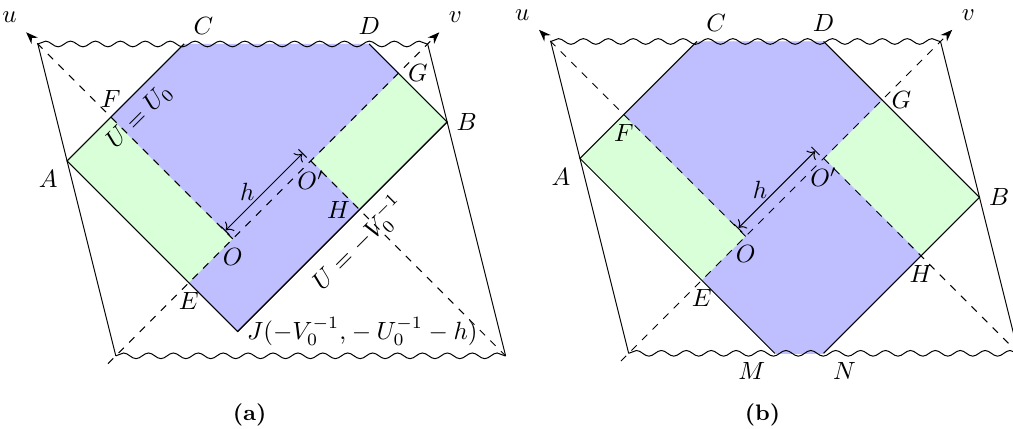
Figure 5. Illustration of the Penrose diagram for the shockwave geometry. Left (5a): the patch only intersects with future singularity; right (5b): the patch intersects with both singularities. The bulk regions whose actions are time-independent are colored in green while those whose actions are time-dependent are colored in